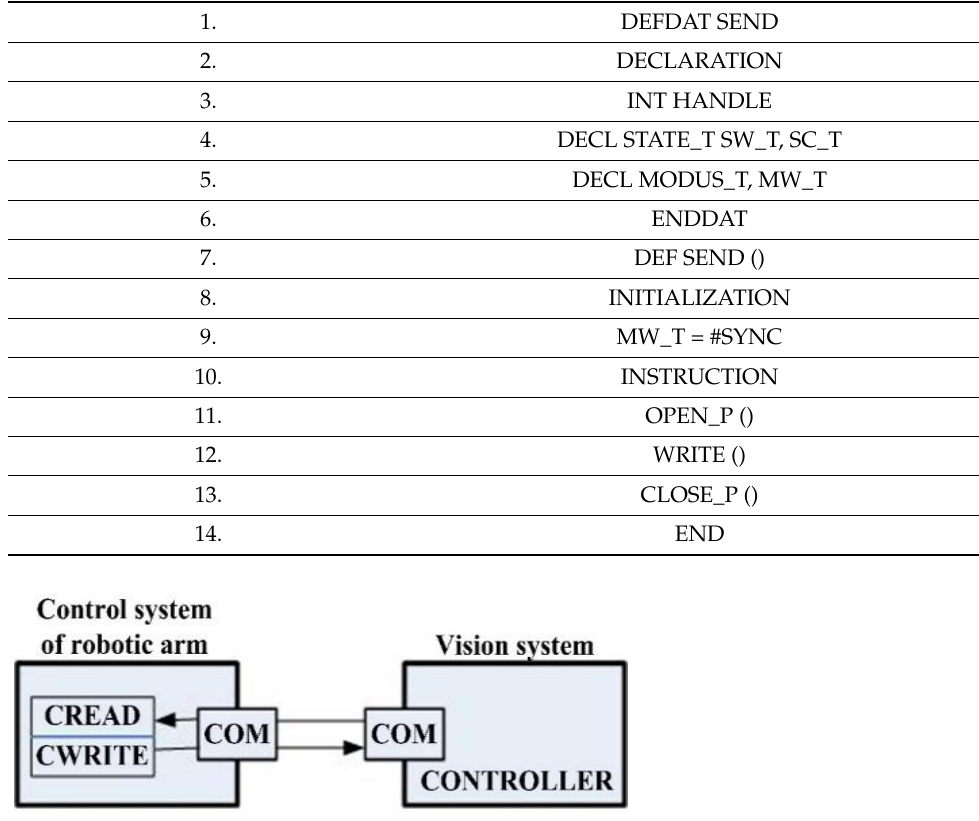
Table 3. An example of successful communication between both systems (vision system and control system of robotic arm).